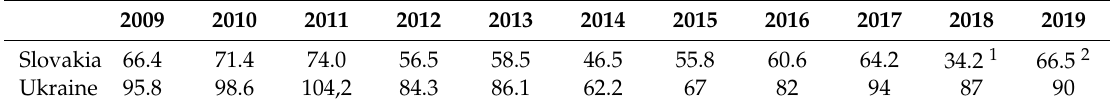
Table 2. Transit of natural gas via Slovak and Ukrainian transmission system (in bcm). Source: [50],